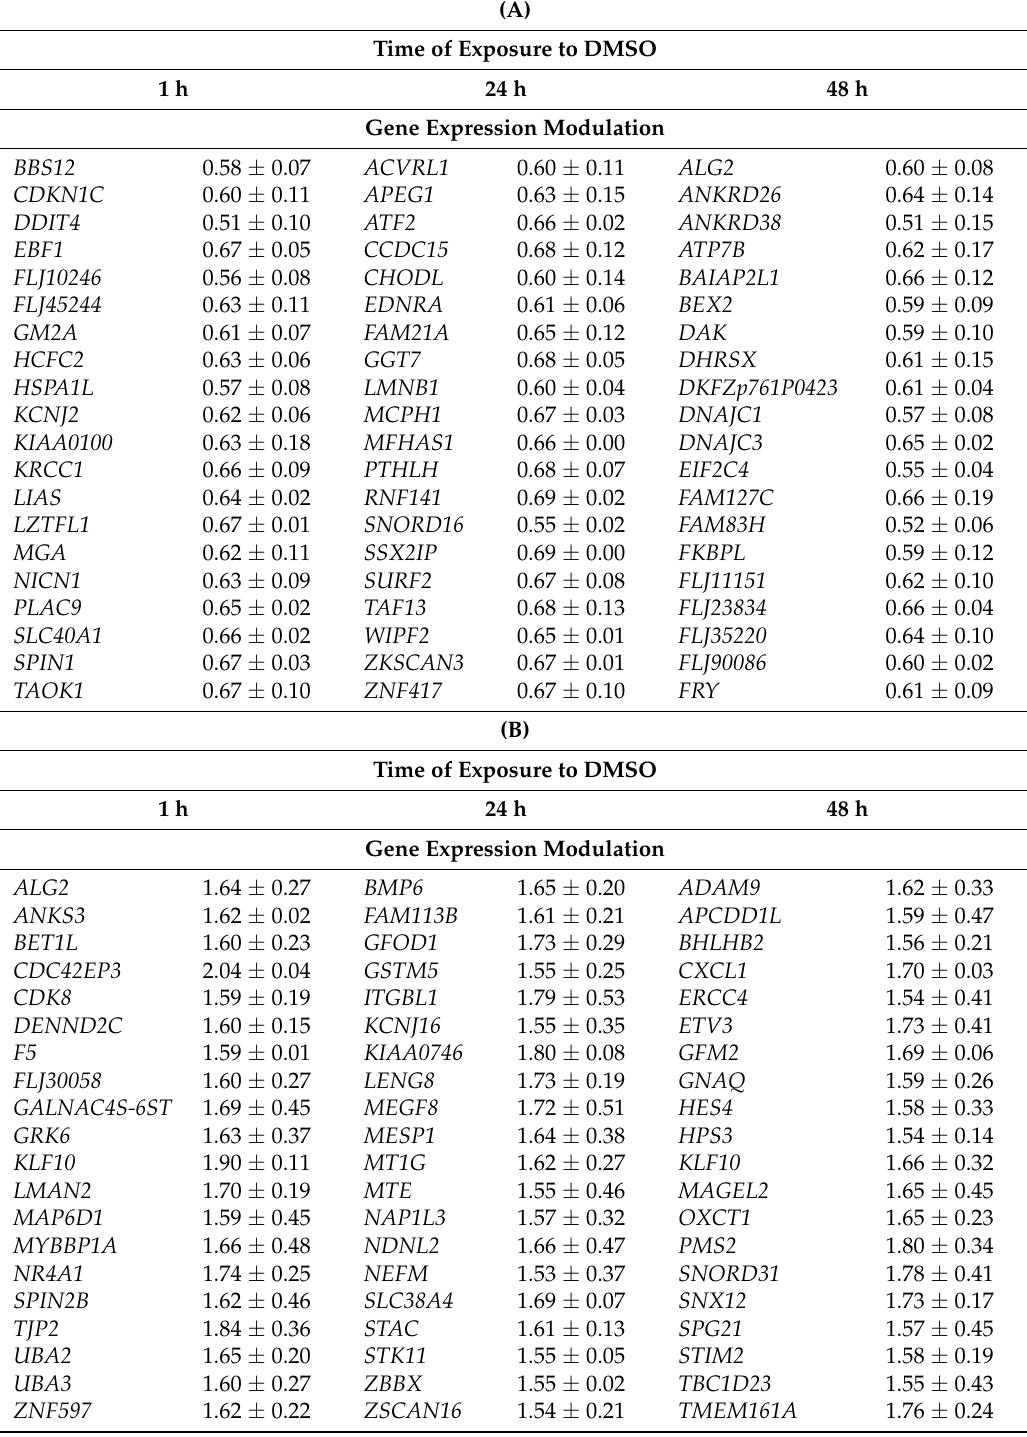
Table 2. Expression level of selected genes with the most changed activity profile after 1, 24 and 48 h treatment with 0.05% DMSO of HDFa. Normalised to untreated cells, relative genome microarray values ± standard deviation from n = 3 denote differences for samples incubated with 0.05% DMSO. Alterations in mRNA levels of genes are referred to FC ≤ 0.7 ( A ) and FC ≥ 1.3 ( B ) with the p -value <